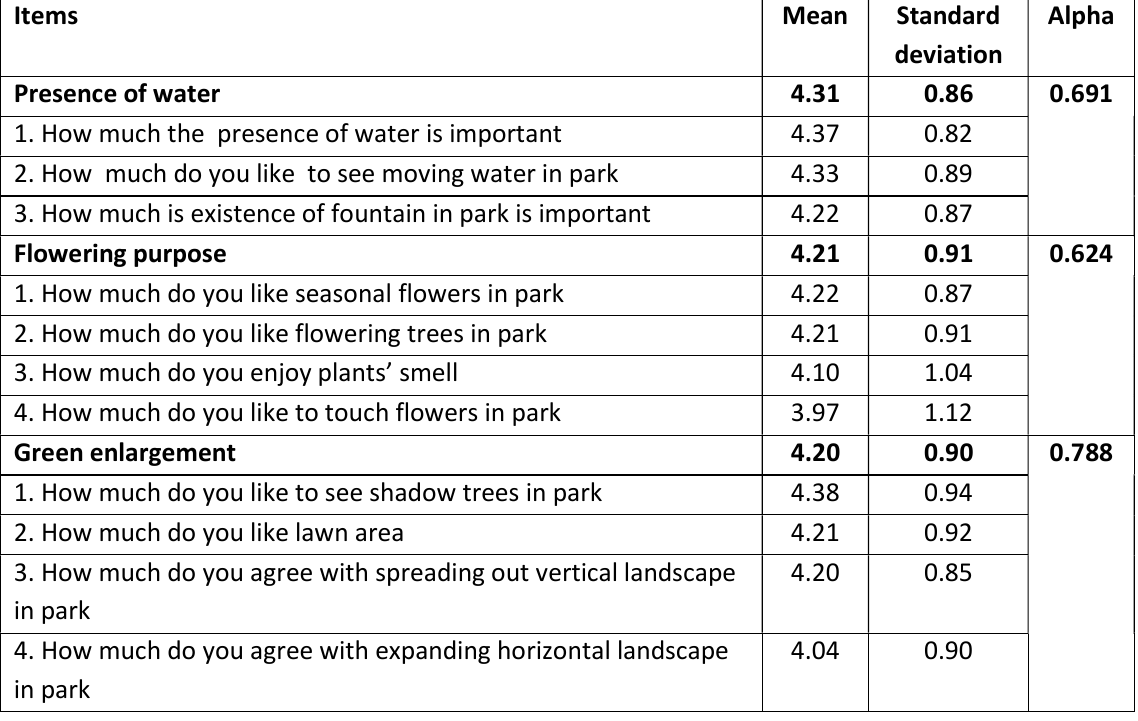
Table 3: Public Preferences for Landscape Function in